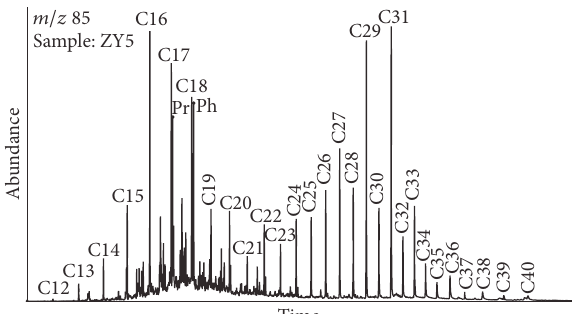
Figure 2: Gas chromatogram of typical n-alkanes and isoprenoid alkanes of sediment core